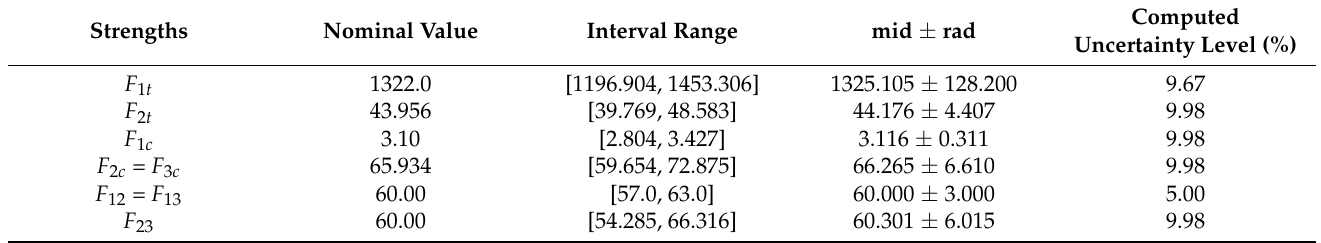
Table 9. Nominal values and computed uncertainty intervals of strengths of the 21xK43-LY556 composite